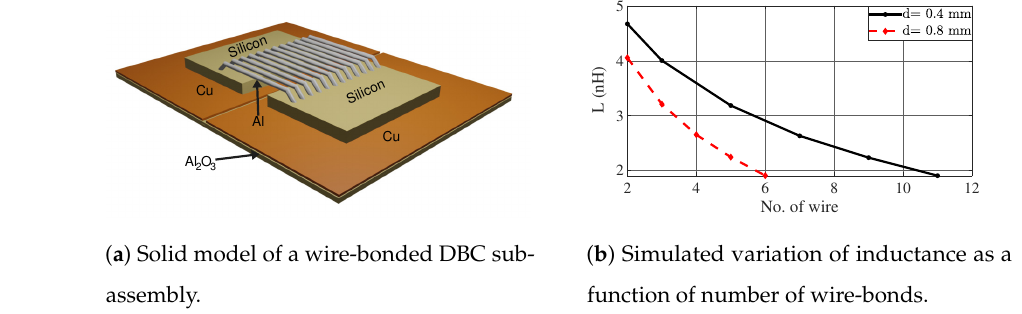
Figure 4. FE analysis of the wire bonds ( a ) the model and ( b ) the dependence of inductance on the number of wires and distance between two